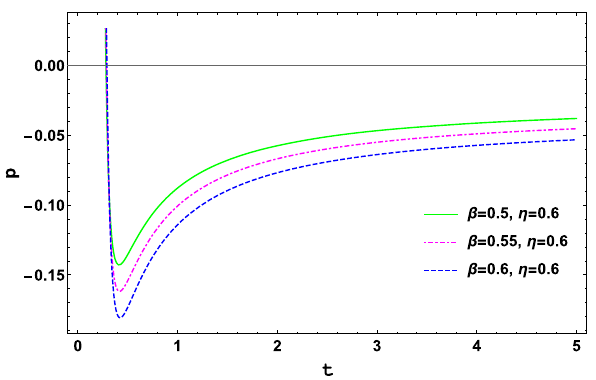
Fig. 16 Variation of pressure against time with m = 0 . 2, n = 0 . 05, λ = 0 .